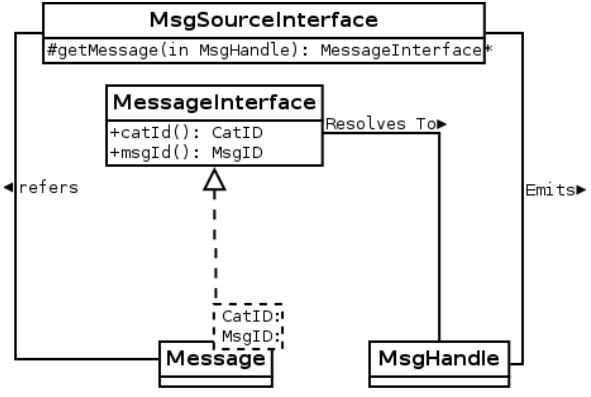
Figure 4. Class Diagram for Message